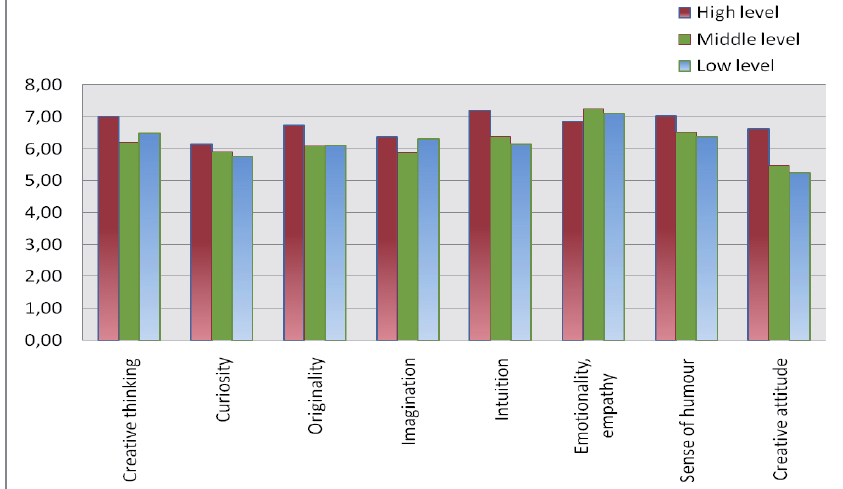
Fig. 6. Indicators of creativity in the groups with different level of self-regard